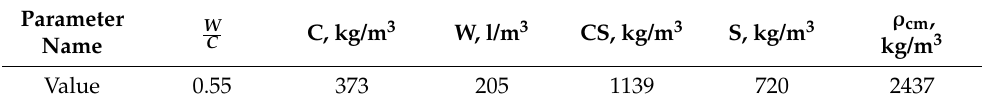
Table 6. Parameters of the composition of the concrete mixture. Parameter